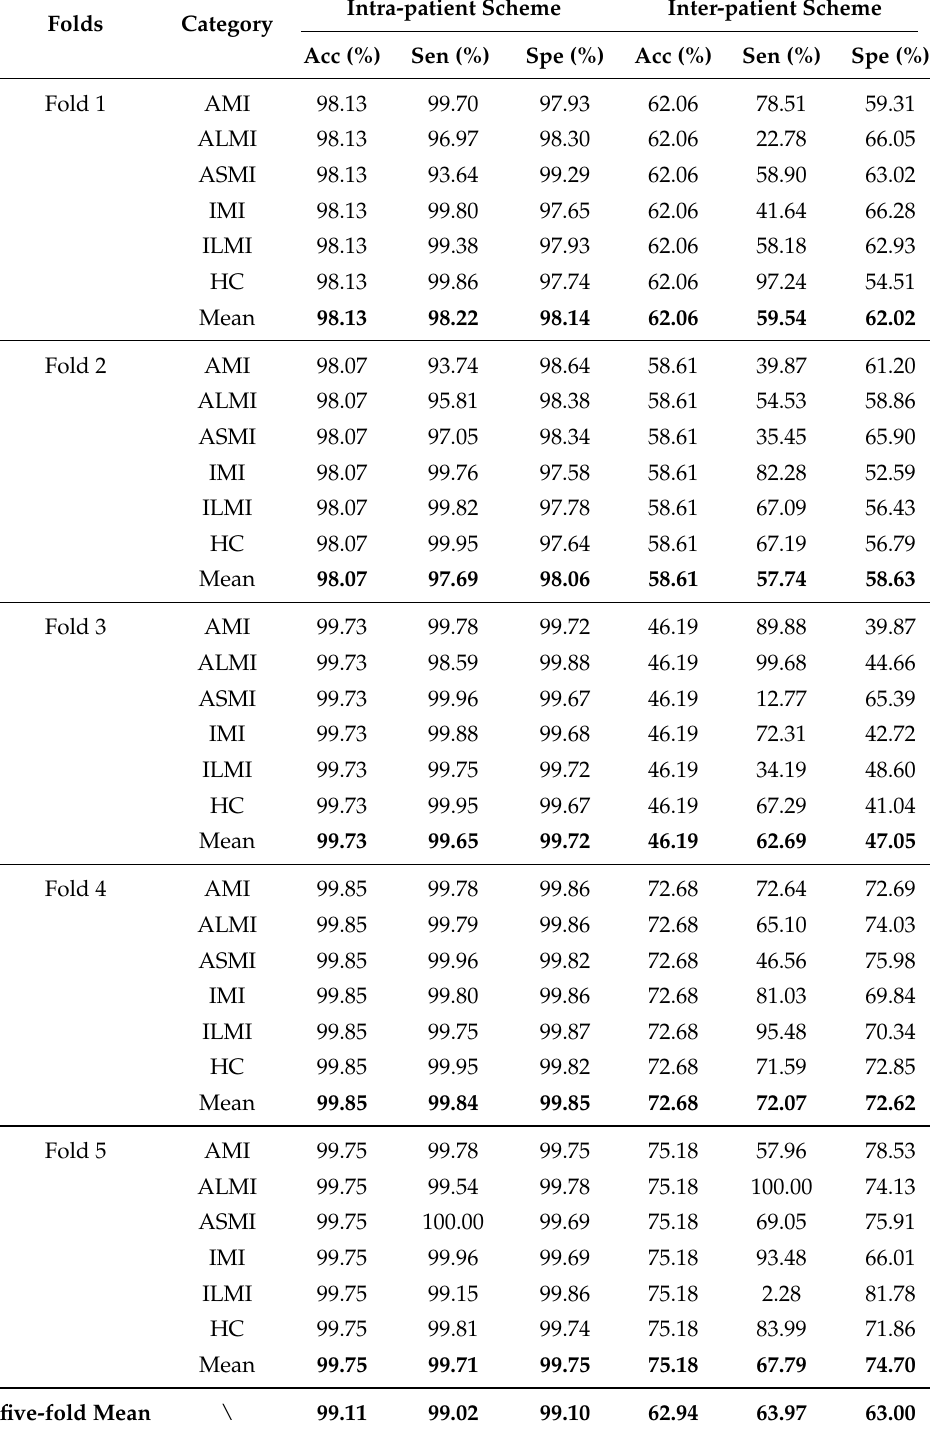
Table 5. Results on MI location by five-fold